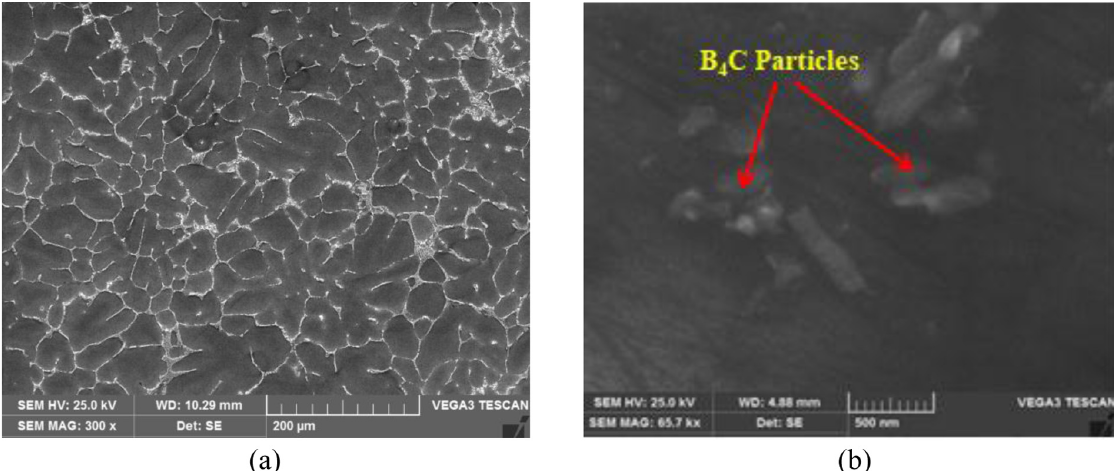
Fig. 5. Scanning electron microphotographs of (a) as cast Al2214 alloy (b) Al2214-8 wt.% of B 4 C composites.